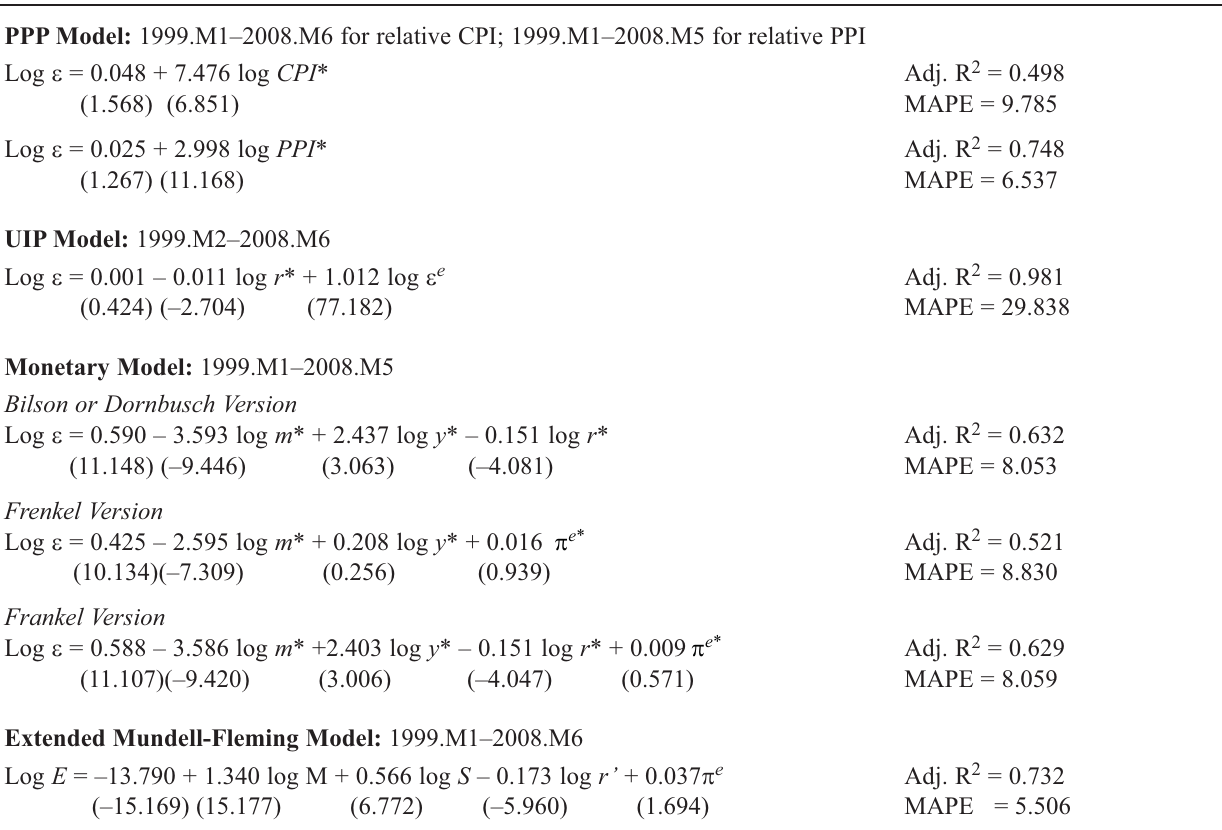
Table 1. Estimated regressions of the USD/EUR exchange